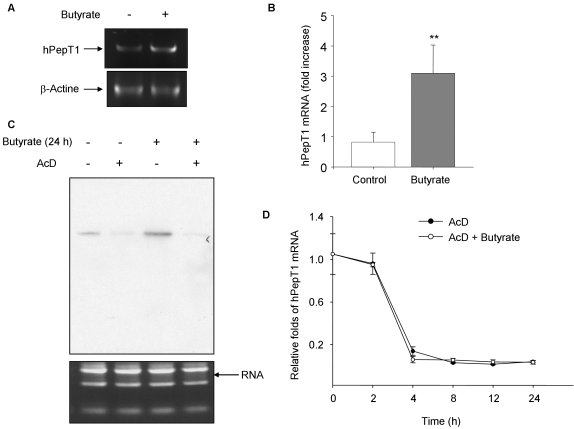
Butyrate transcriptionally up-regulates hPepT1 expression in Caco2-BBE cells.Caco2-BBE cells were treated with 5 mM butyrate for 24 h and hPepT1 mRNA levels were assessed by A) semi-quantitative RT-PCR and B) real-time RT-PCR. Values represent means±S.E. of three determinations. **P<0.005 vs control. To examine butyrate effect on the stability of hPepT1 mRNA, cells were pre-incubated with 5 µg/ml Actinomycin D (AcD) for 30 min and then treated with butyrate for 24 h. C) Total RNA was analyzed by Northern blot using a probe specific to the hPepT1 transcript. RNA loading controls were shown as bottom panel. D) hPepT1 mRNA levels were quantified using real-time RT-PCR. Values expressed as normalized cycling threshold values relative to untreated (0 h) cells represent means±S.E. of three determinations.